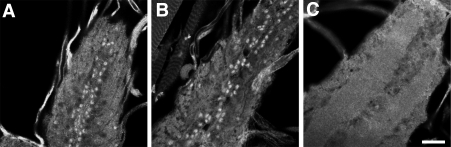

Imp Mutations Do Not Disrupt the Nuclear Accumulation of pMad(A) In wild type, pMad is readily detected in the nuclei of motorneuron ganglia.(B) Nuclear uptake of pMad is retained in the Imp transheterozygous H44/H149 mutant background.(C) In contrast, pMad staining is abolished in the wit mutant. Bar, 10 μm.